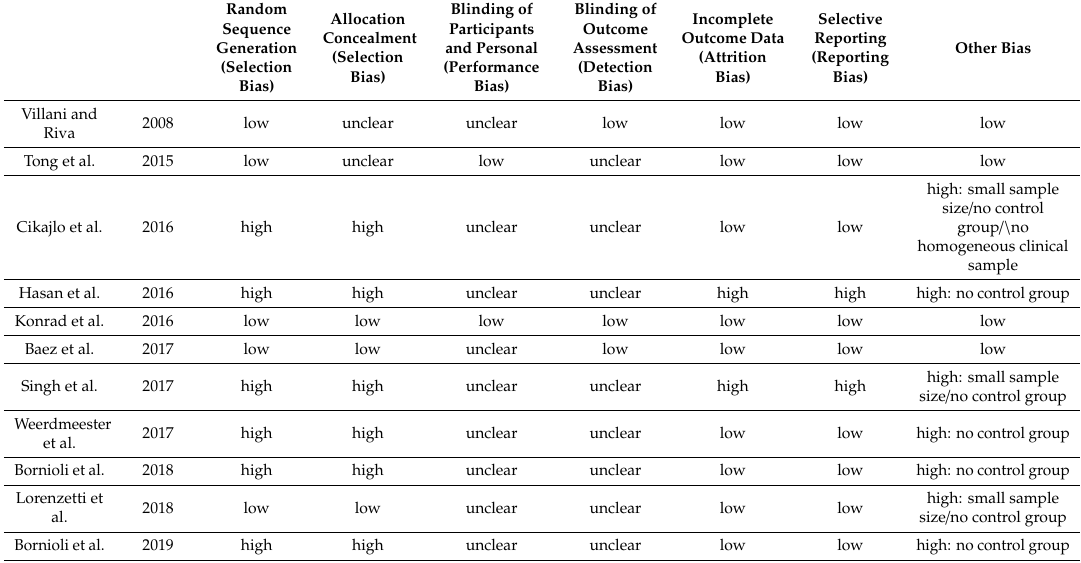
Table 2. Risk of bias